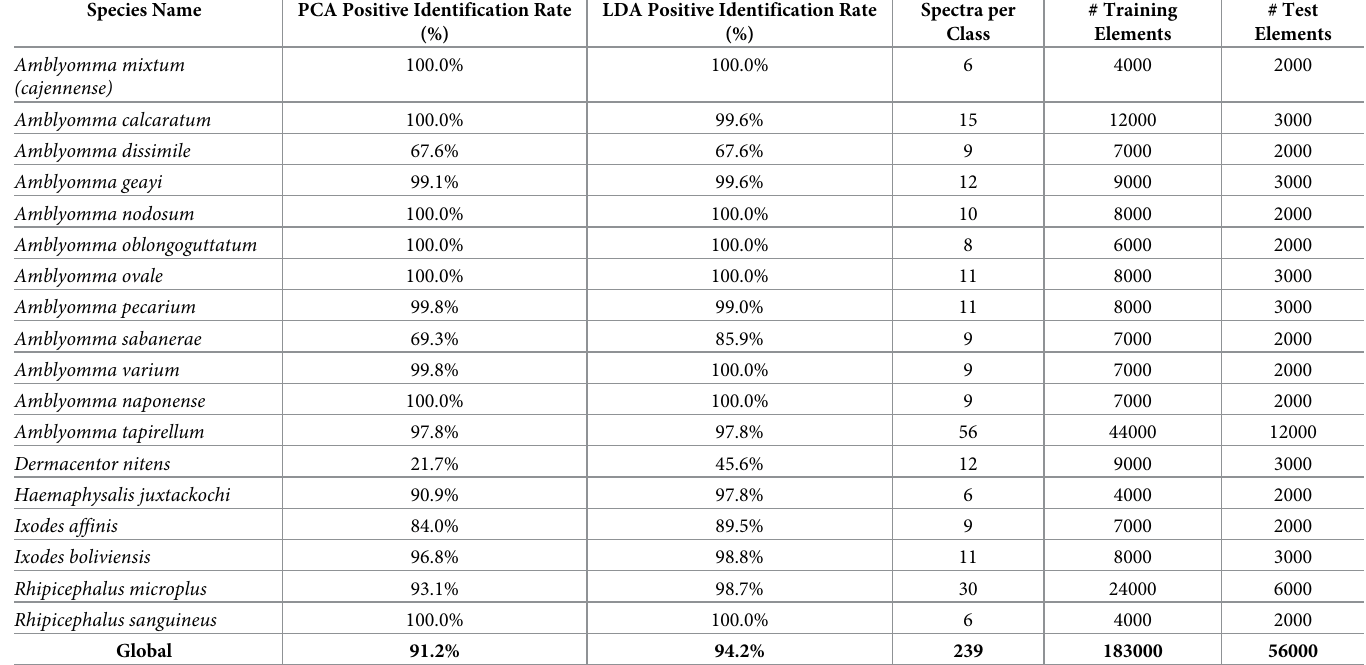
Table 2. Performance of PCA and LDA clustering